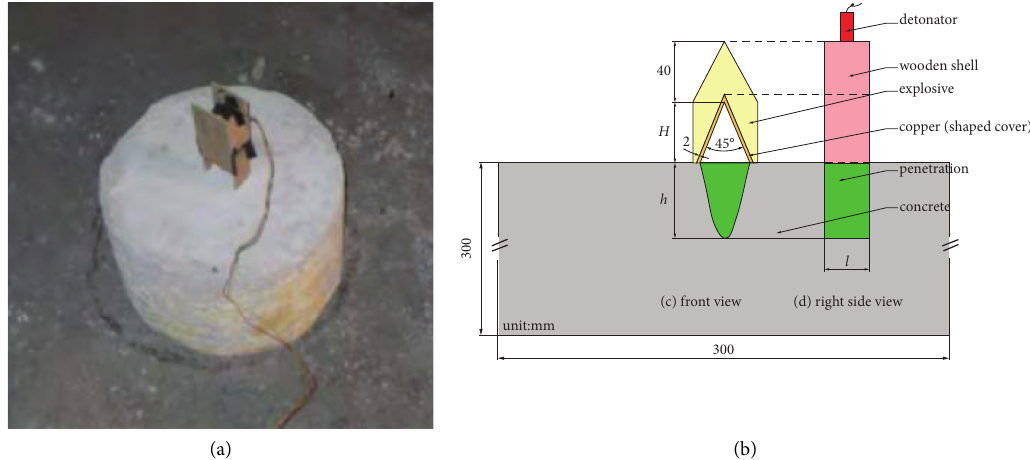
Figure 2: Physical model of mini-linear shaped charge jet penetration induced by top-center detonation.